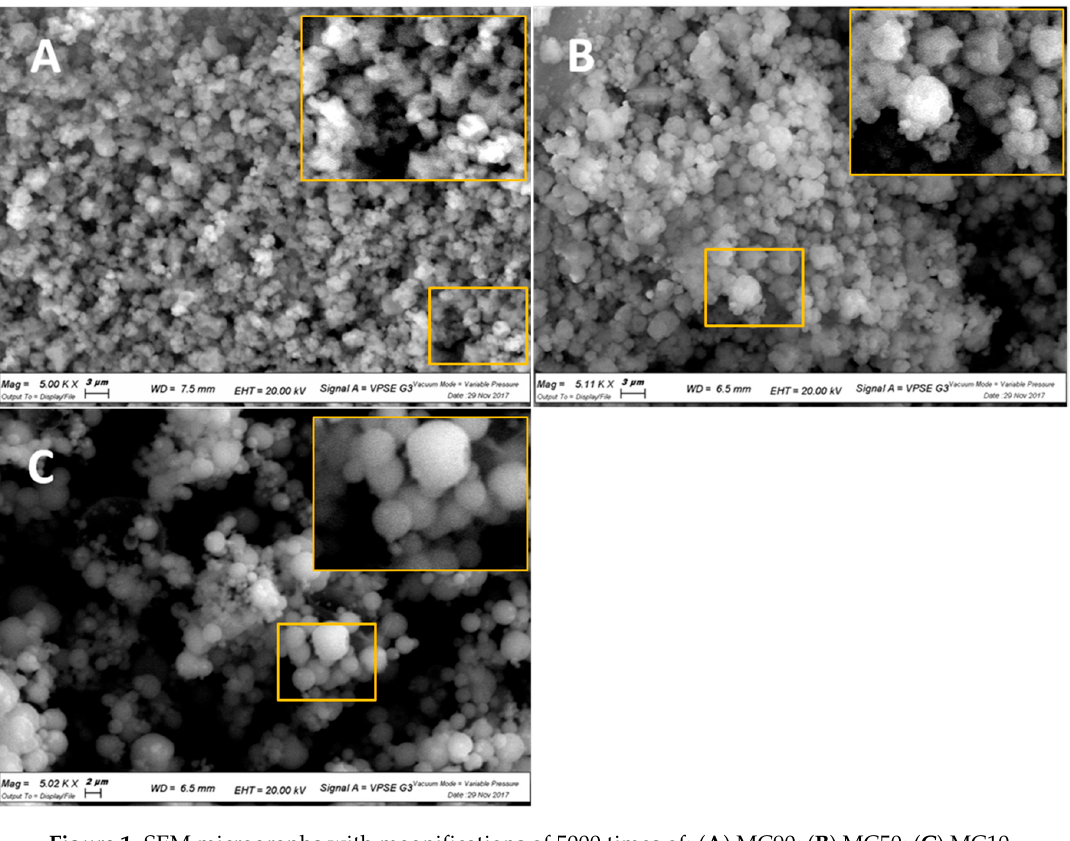
Figure 1. SEM micrographs with magnifications of 5000 times of: ( A ) MC90; ( B ) MC50; ( C ) MC10.